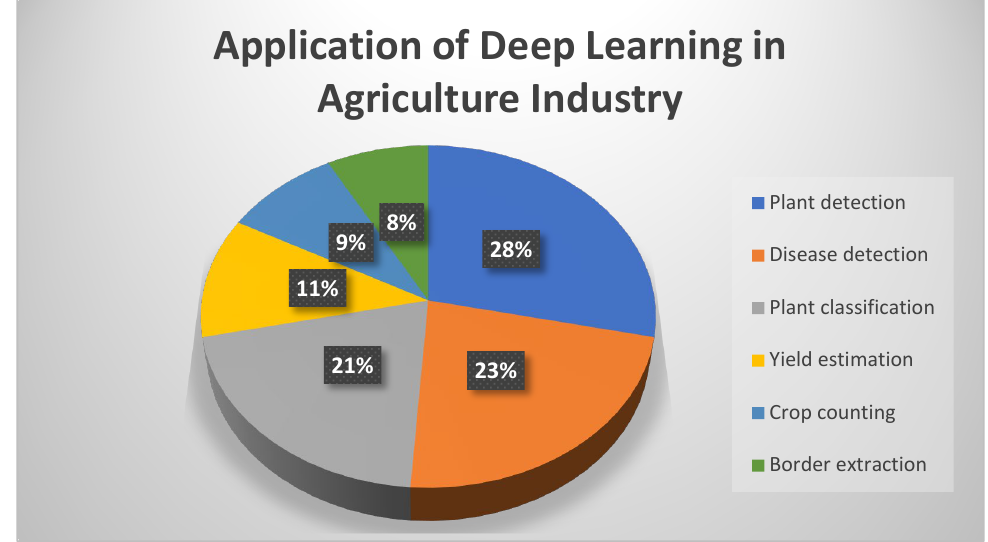
Figure 17. Image annotation applications in agriculture industry.